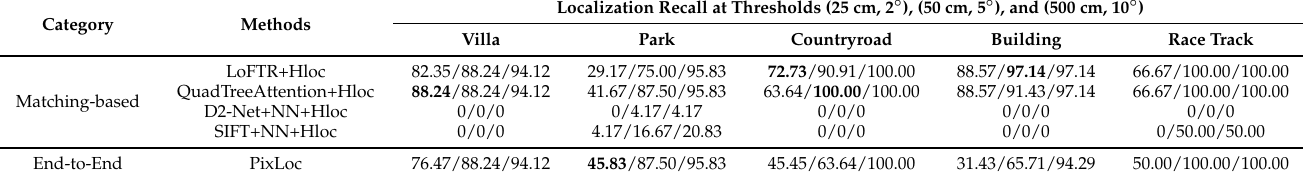
Table 8. We report the localization recall at thresholds (25 cm, 2 ◦ ), (50 cm, 5 ◦ ), and (500 cm, 10 ◦ ). The best results are in